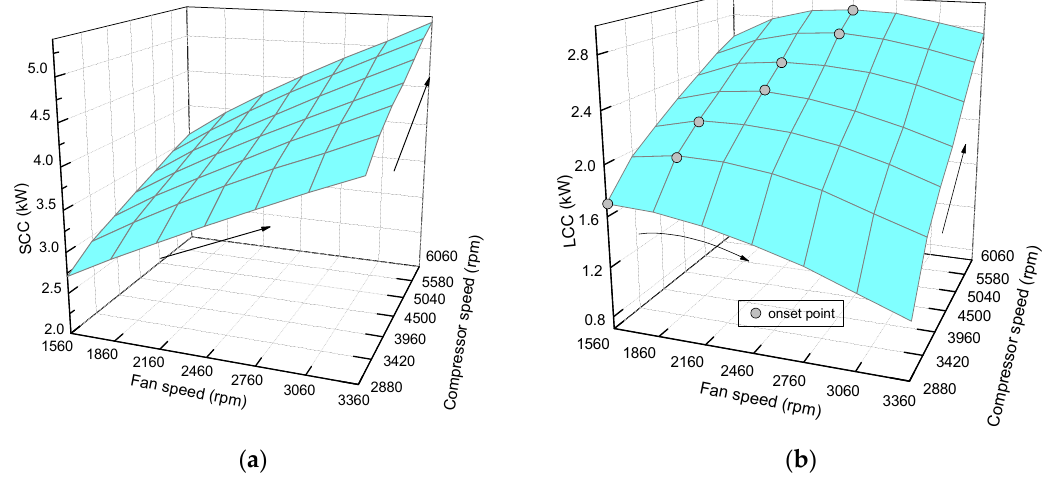
Figure 7. SCC and LCC under different speed combinations of compressor and supply fan, ( a ) the variation of SCC; ( b ) the variation of LCC.